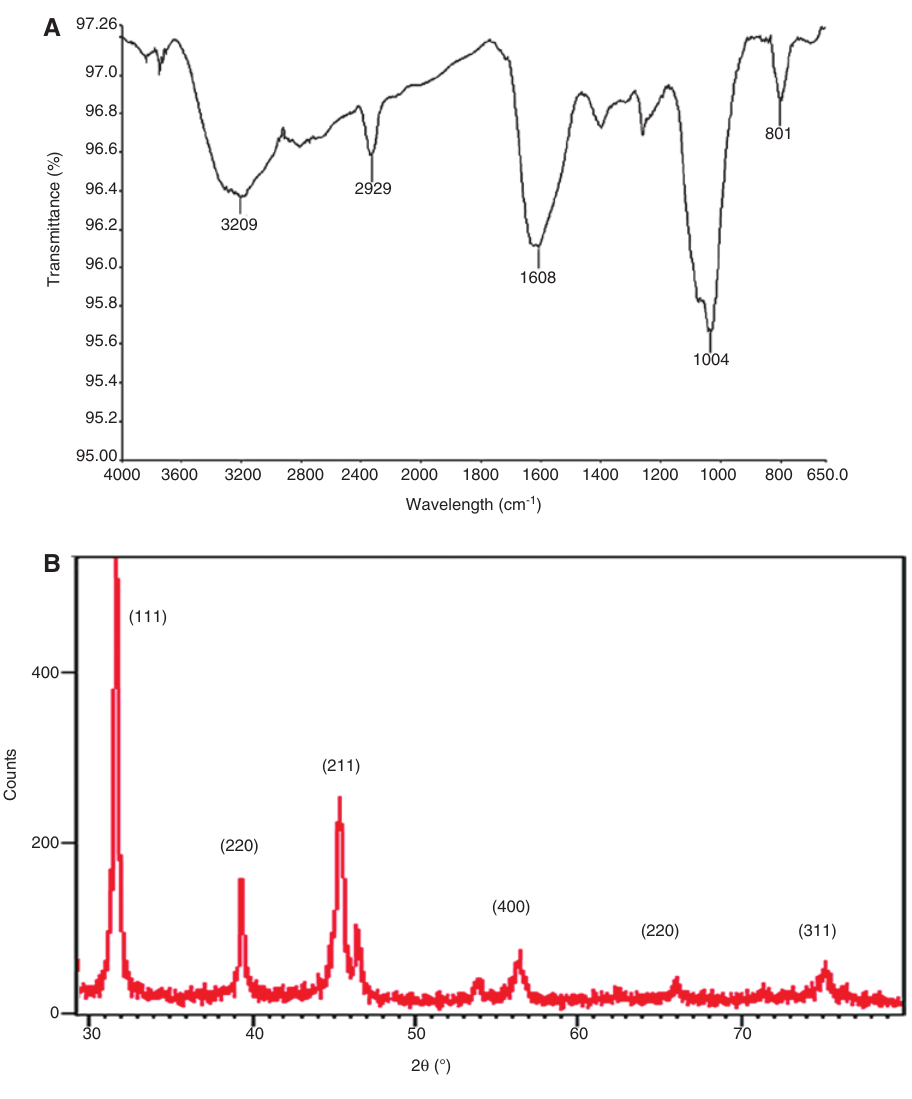
, 40 ° C, and 45 min). 3